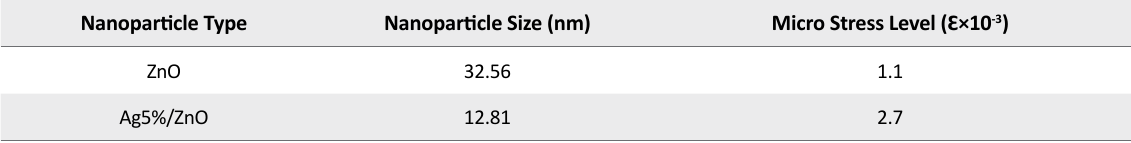
Table 2. Micro stress level of nanoparticles synthesized using sol-gel process Nanoparticle